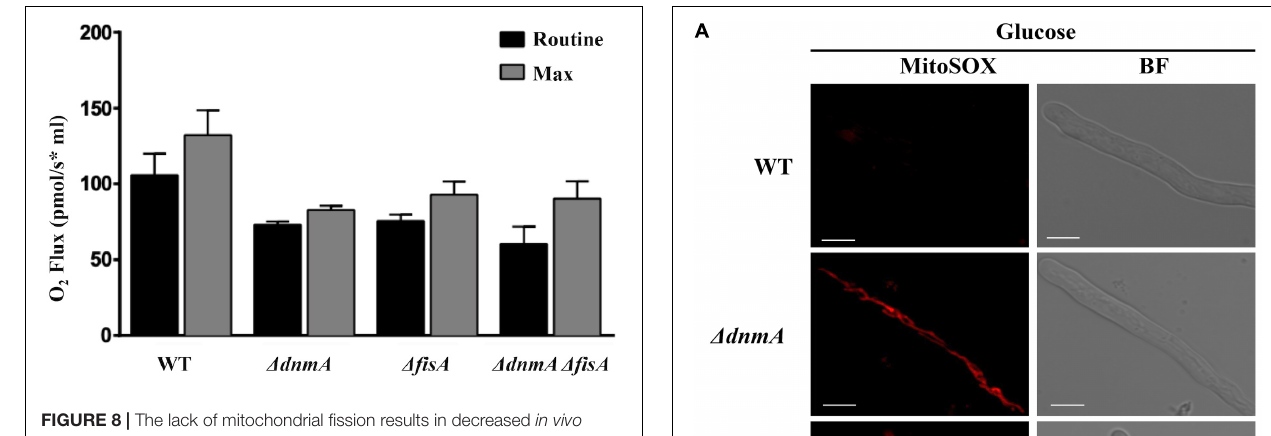
FIGURE 8 | The lack of mitochondrial fission results in decreased in vivo respiration. Conidia from strains TRV1 (WT), CVG1 ( (cid:49) dnmA ), CVG2 ( (cid:49) fisA ), and CVG3 ( (cid:49) dnmA (cid:49) fisA ) were incubated in supplemented glucose-MM for 4 h, washed three times with ice-cold MM without glucose and maintained on ice until used for respiration measurements. Respiration was determined using an Oroboros high-resolution respirometer, as indicated in section “Materials and Methods.”